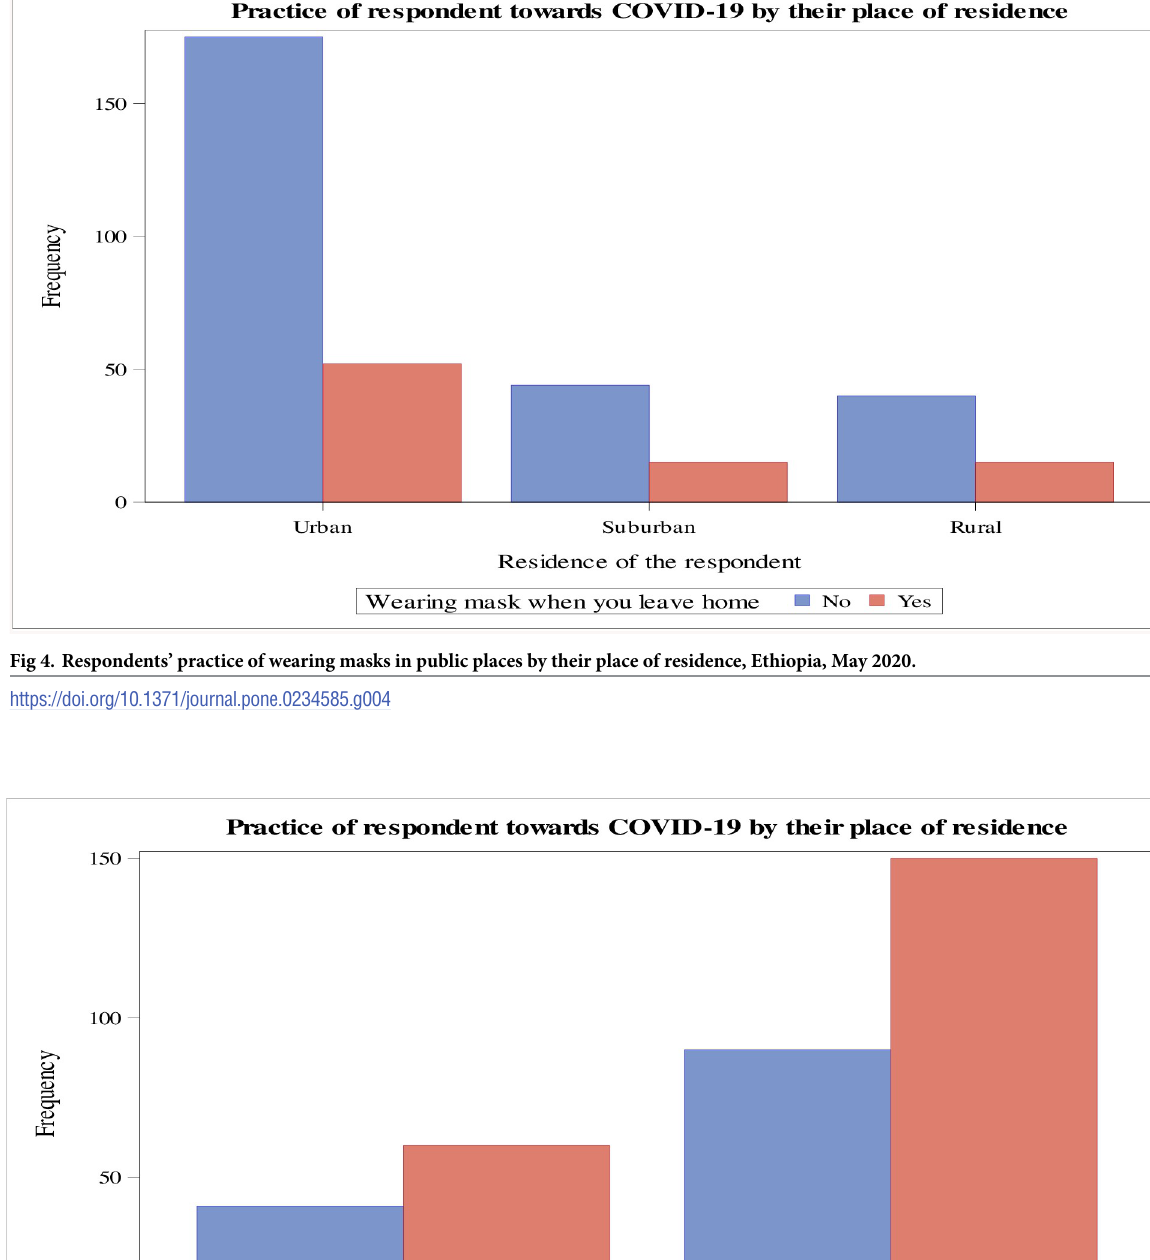
PLOS ONE | https://doi.org/10.1371/journal.pone.0234585 January 28, 2021 9 /